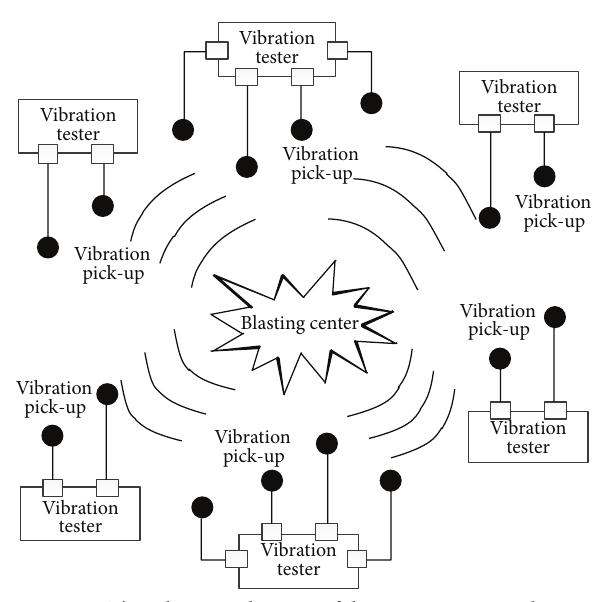
Figure 7: The schematic diagram of the measuring point